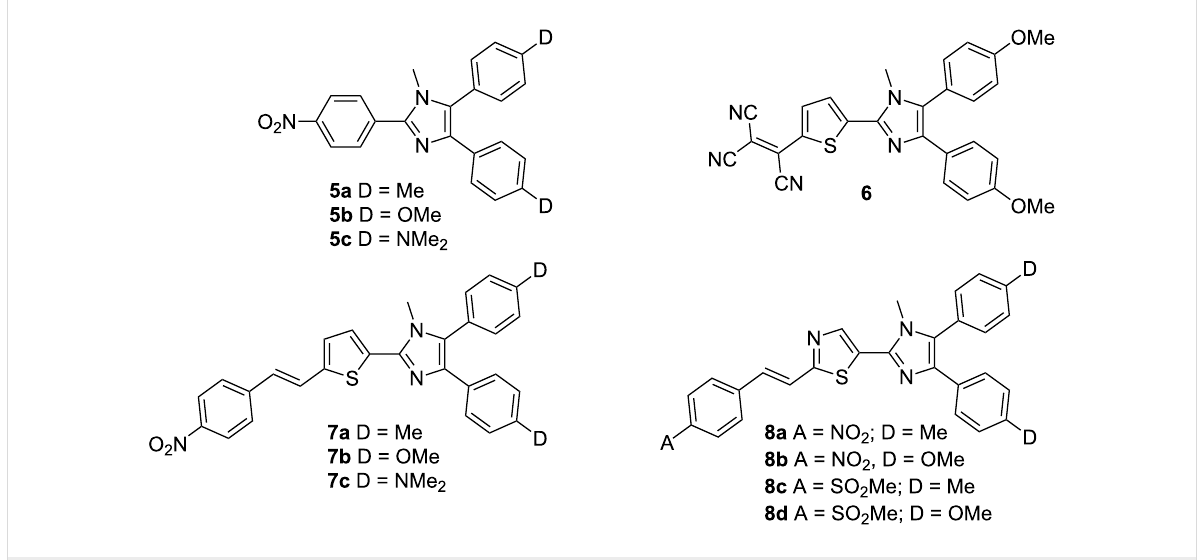
Figure 4: Y-shaped CT chromophores with an extended π -conjugated pathway and various donor and acceptor substitution patterns [16,33-35].